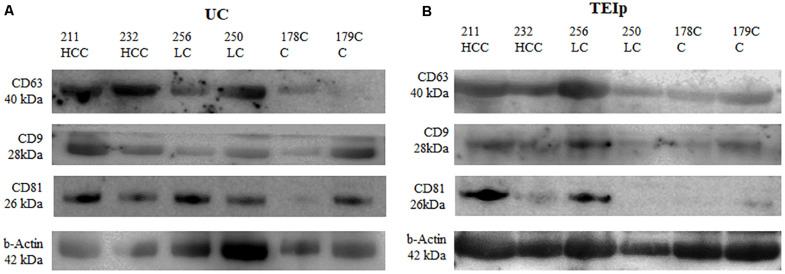
Positive detection for specific exosomal surface markers (CD 63, CD9, and CD81) and for the control-positive marker (b-actin) by immunoblotting. (A) exosomes isolated by UC and (B) TEIp kit.